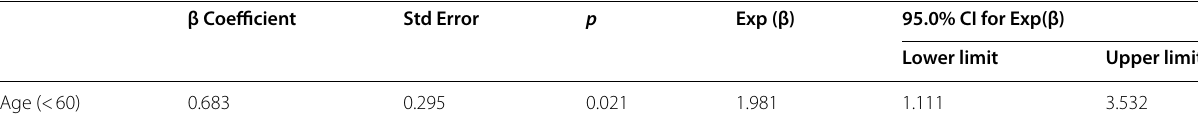
Table 5 Factors affecting progression after the first treatment, Cox regression analysis